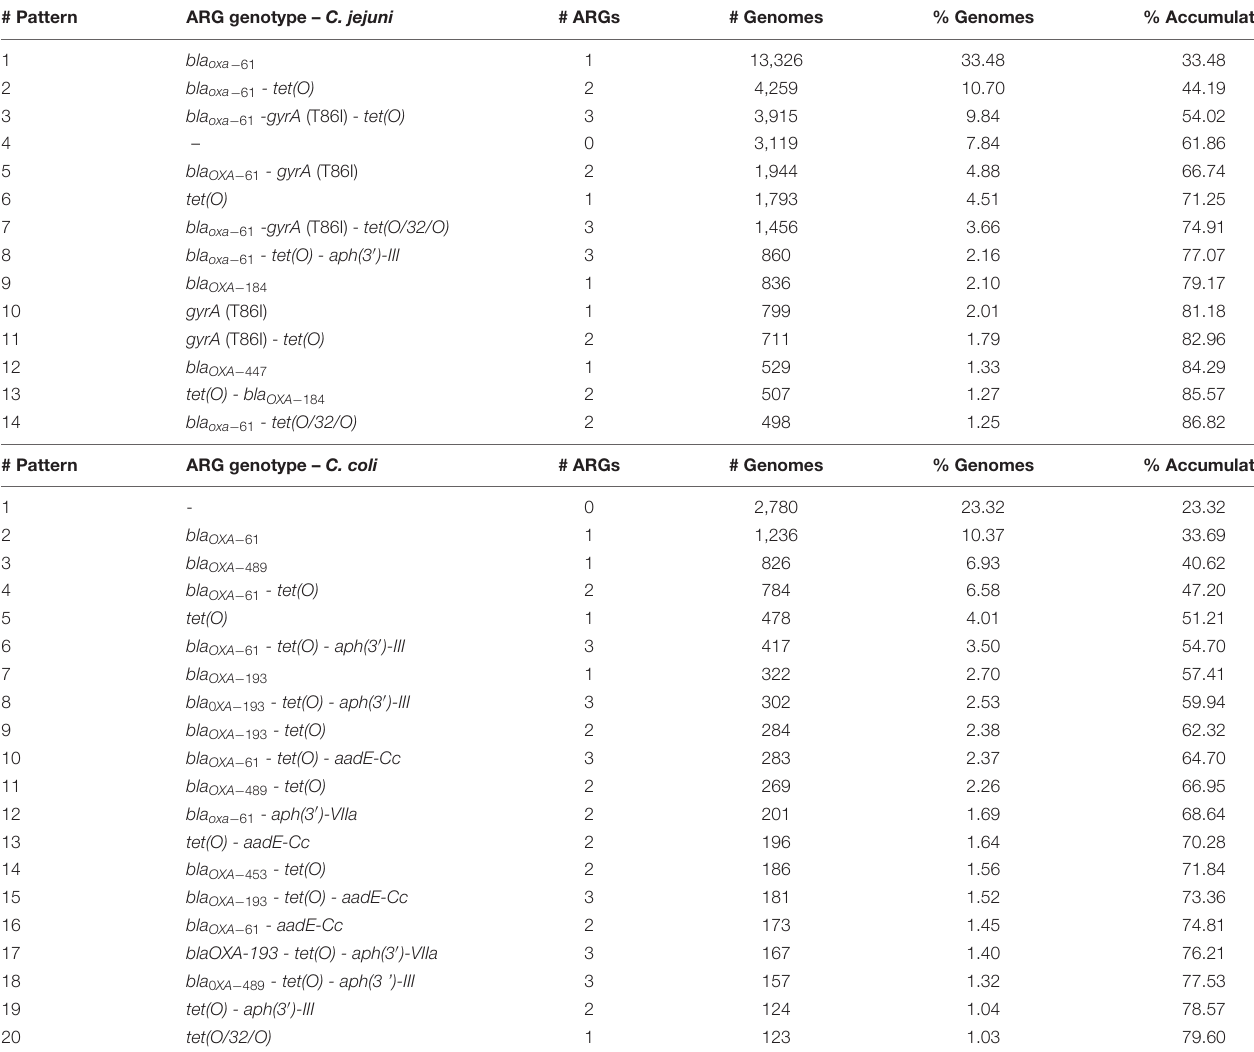
TABLE 1 | Most abundant ARG genotypes on the C. jejuni and C. coli genomes analyzed, ordered by decreasing relative